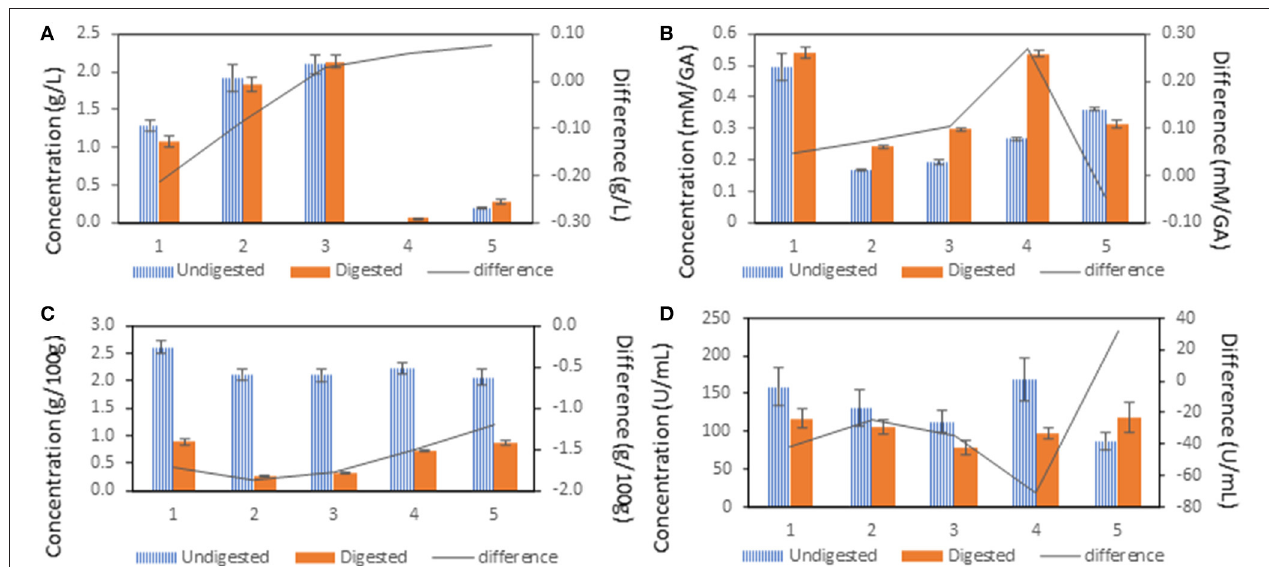
FIGURE 3 | The influence of treatment of pea flour [(1): untreated flour, (2): cooked at 100 ◦ C for 10min, (3): cooked at 100 ◦ C for 120min, (4): fermented flour without cooking, (5): fermented flour cooked at 100 ◦ C for 120min.] on antinutritional compounds. The difference was calculated after subtraction of the concentration of the undigested sample from the digested sample. (A) raffinose, (B) polyphenols, (C) phytic acid, (D)